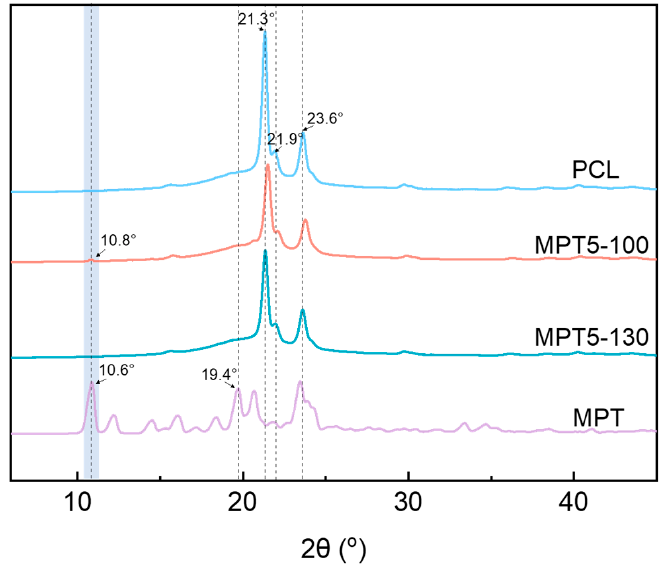
Figure 4. WAXD patterns for PCL/MPT-95/5 at different processing temperatures. The WAXD pattern of the sample MPT5-100 exhibited identical peaks of PCL, in- dicating that the addition of 5 wt% MPT does not affect the crystallization of PCL. A slight peak at 10.8 ◦ was observed, corresponding to the crystalline conformation of